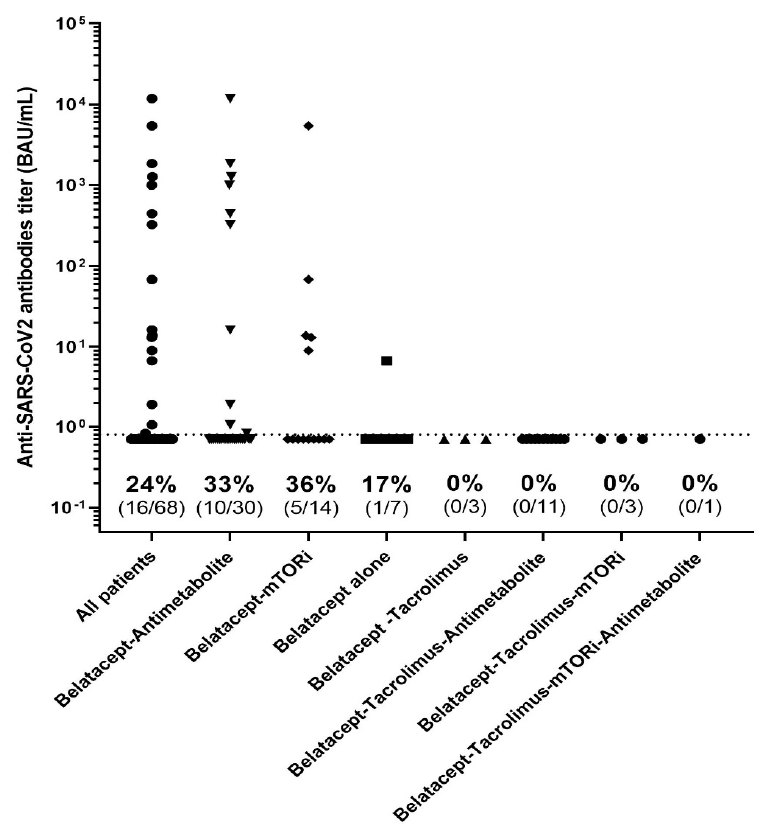
Figure 5. Anti-S results, using the Wantai assay, according to the immunosuppressive